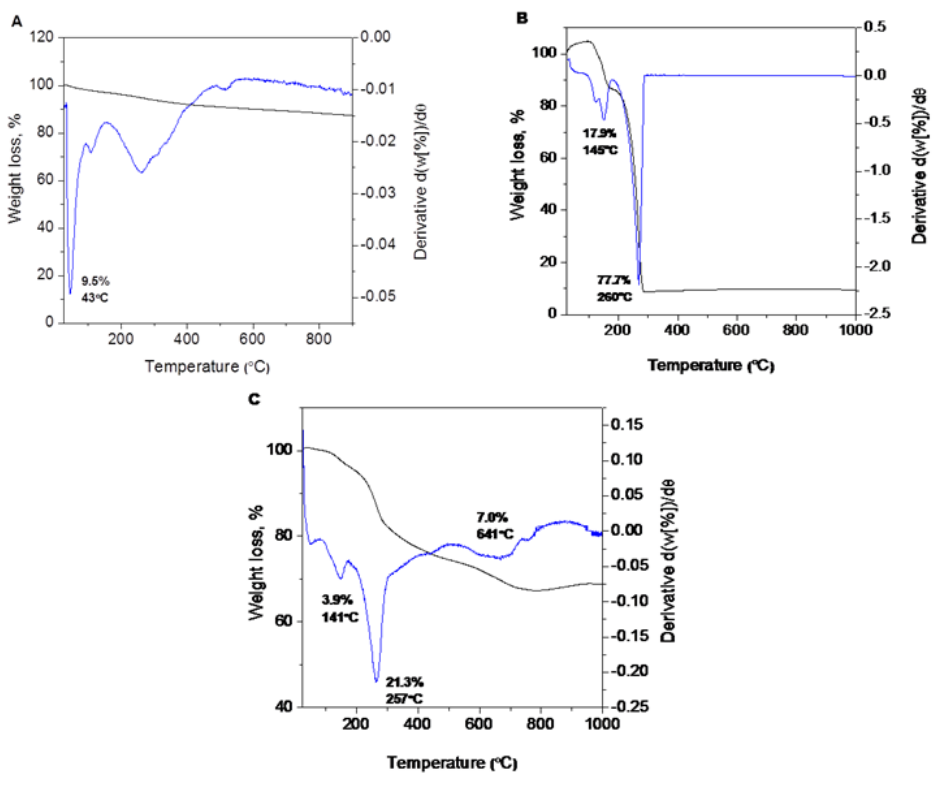
Figure 4. TGA of ( A ) iron oxide nanoparticles; ( B ) perindopril erbumine;